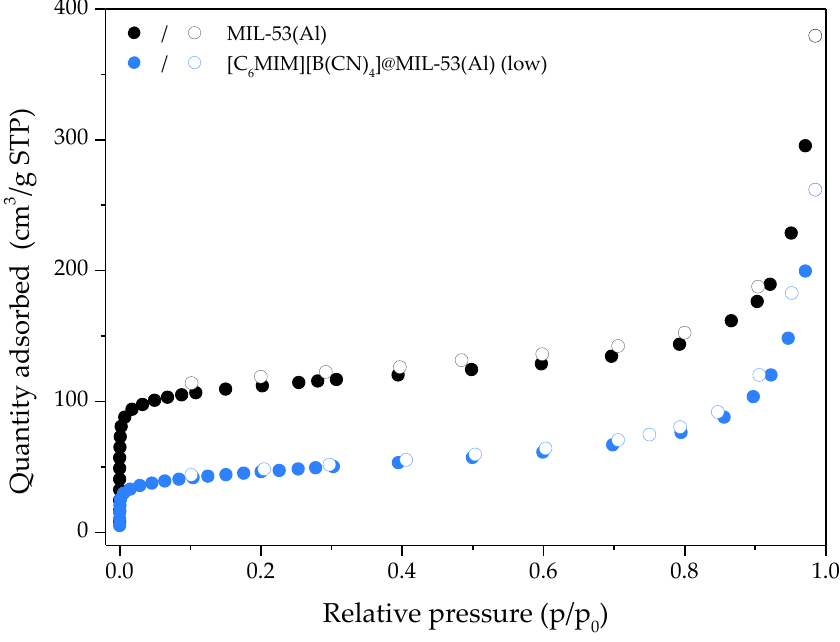
Figure 5. N 2 adsorption/desorption equilibrium isotherms at 77 K of MIL-53(Al) and Figure [C 6 MIM][B(CN) 4 ]@MIL-53(Al) (low). Closed and open symbols denote the adsorption and desorp- tion data, respectively.